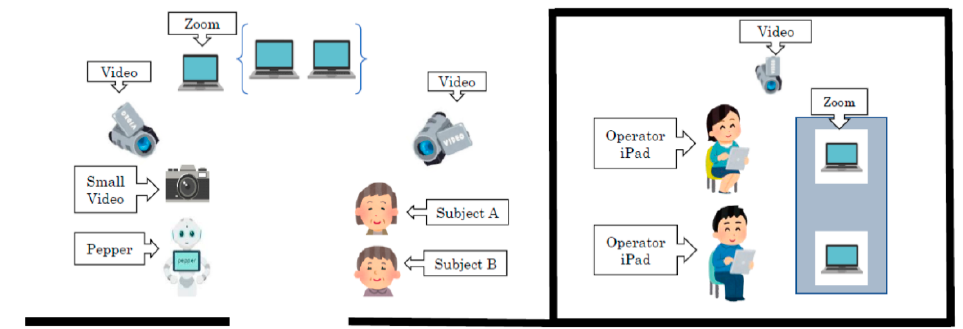
Figure 3. The situation of Pepper interacting with subjects.